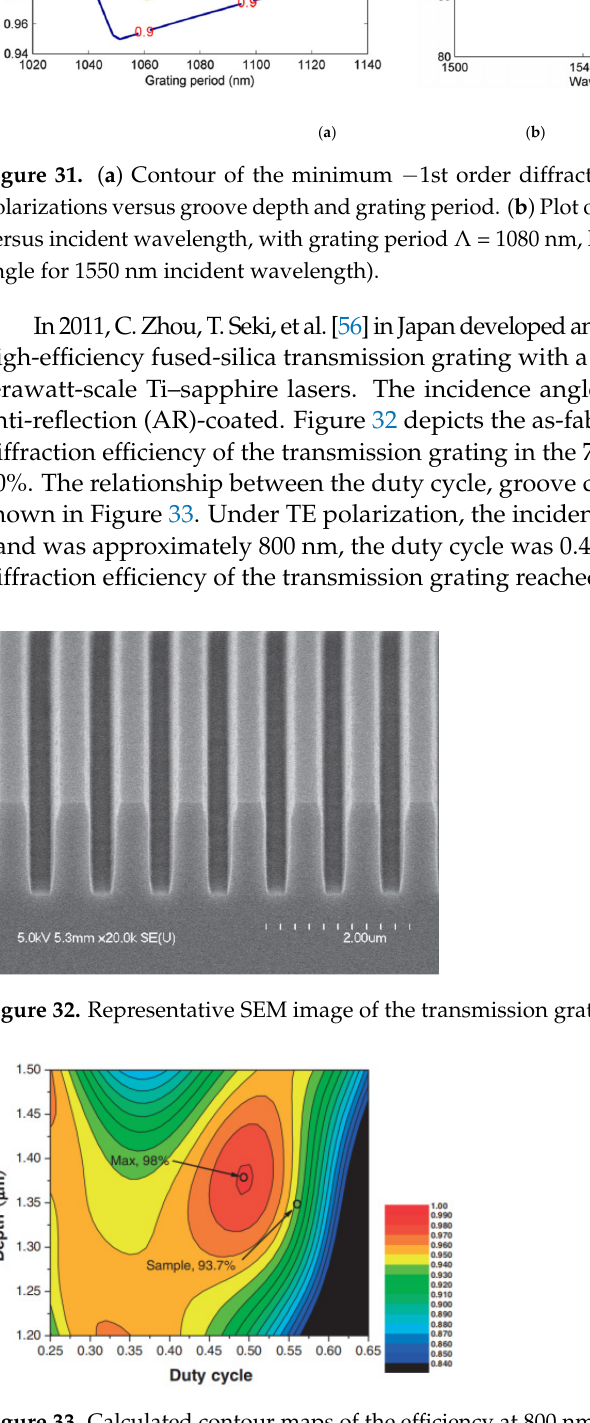
Figure 33. Calculated contour maps of the efficiency at 800 nm with an incidence angle of 30° for TE polarization. The horizontal and vertical axes are the duty cycle and depth of grooves, respectively. The maximum efficiency was 98%, with a duty cycle of 0.49 and depth of 1380